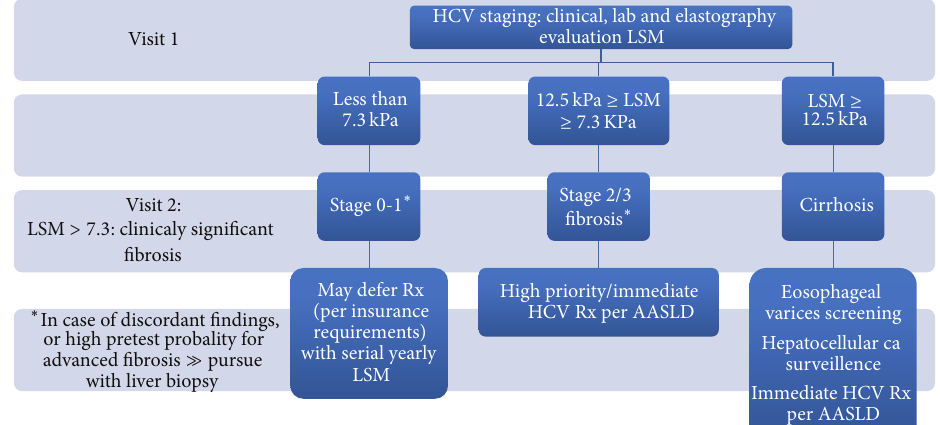
Transient Elastography Clinical Use Checklist for Reliable Interpretation of